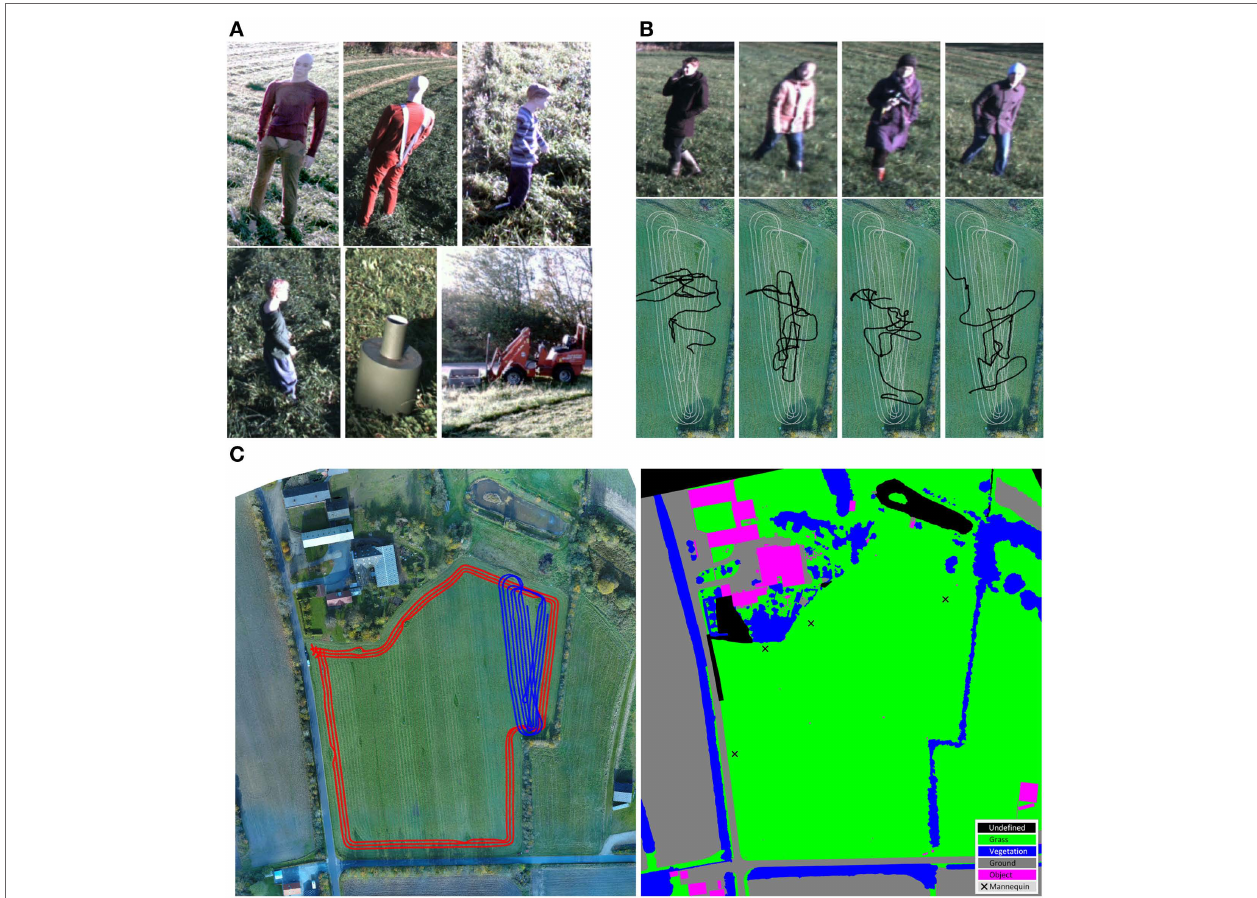
FIGURE 8 | FieldSAFE dataset. (A) Examples of static obstacles. (B) Examples of moving obstacles (from the stereo camera) and their paths (black) overlaid on tractor path (gray). (C) Colored and labeled orthophotos. Left: orthophoto with tractor tracks overlaid. The red track includes only static obstacles, whereas the blue track also has moving obstacles. Right: annotated orthophoto with pixel-wise labels. Adapted from Kragh et al. (2017) with permission. Written and informed consent was obtained from all depicted individuals.